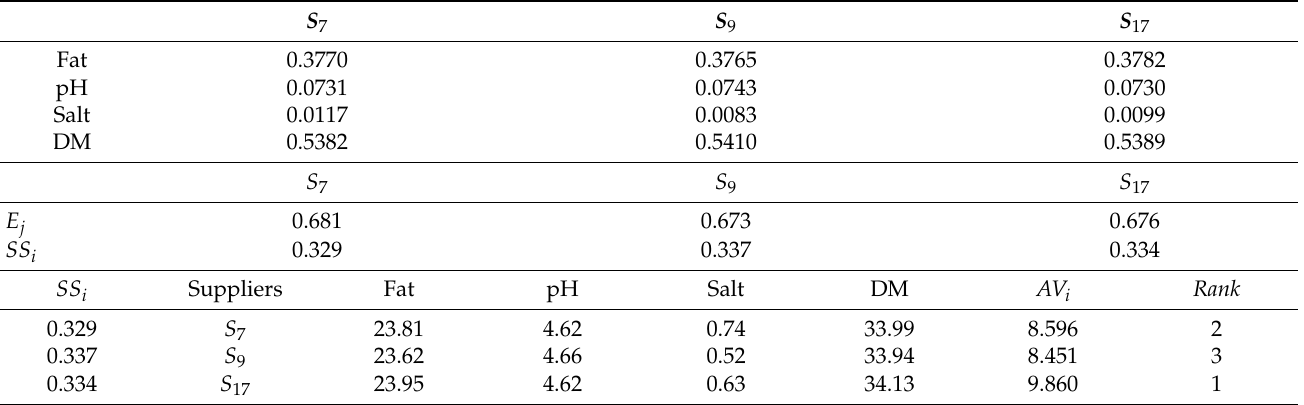
Table 16. The normalized transformed benefit matrix, entropy ( 𝐸 𝑗 ), ( 𝑆𝑆 𝑖 ), and the final ranking of the cheese suppliers of the second example.